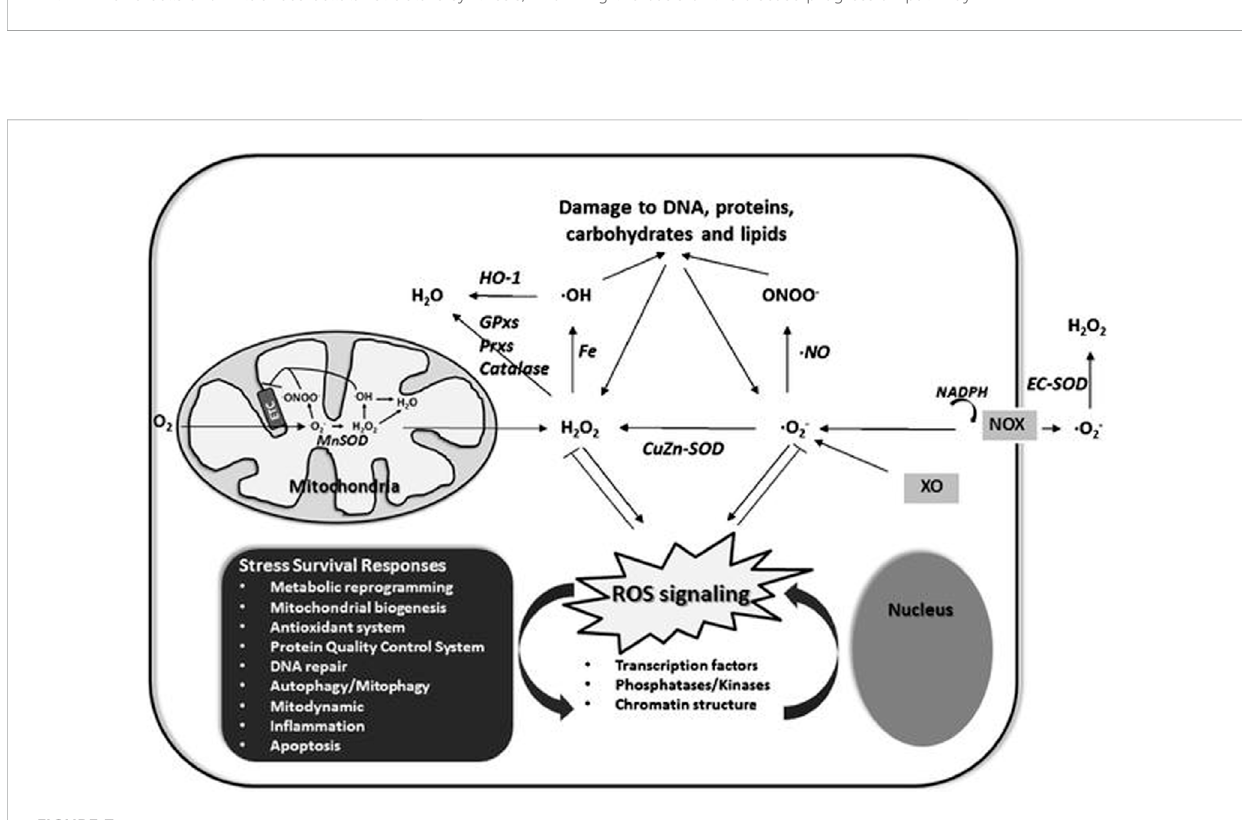
FIGURE 7 A schematic representation of redox homeostasis. Normal cell functions are at optimum levels when the ROS production and elimination rate are equal. An imbalance between the two, especially increased ROS production than elimination, results in oxidation and cell damage.